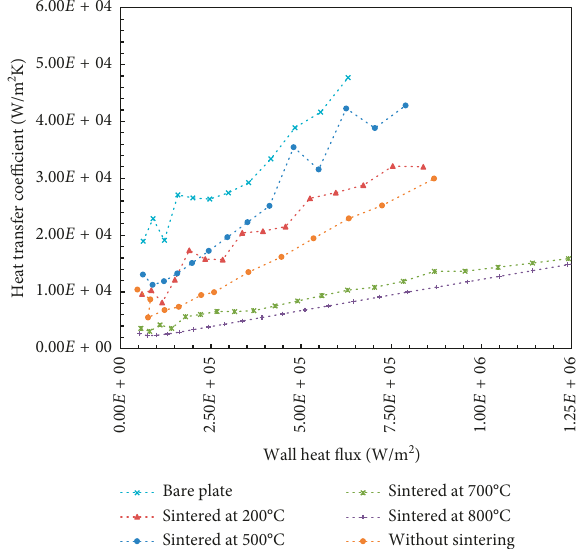
Figure 12: Heat transfer coefficient versus heat flux for bare and sintered plates (first forty minutes EPD coating and then sintered at 200, 500, 700, and 800 ° C).